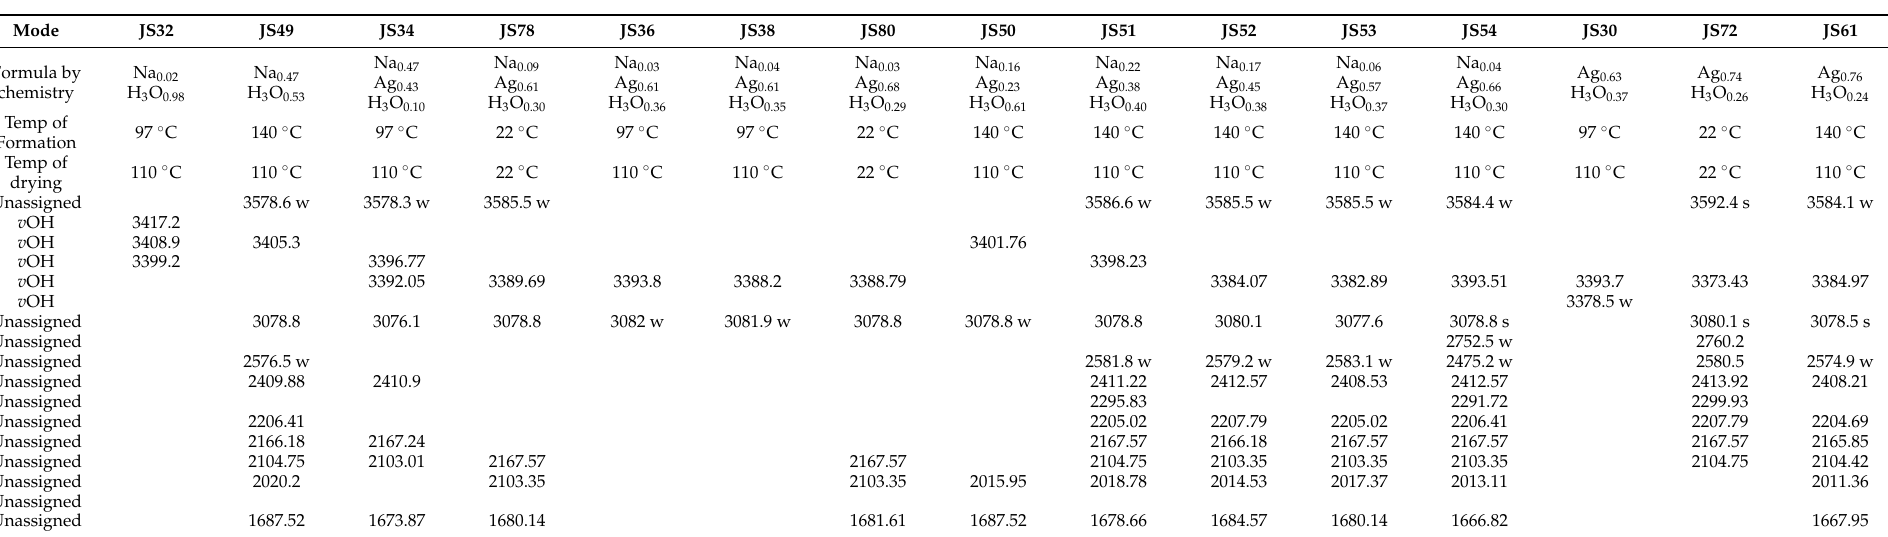
Table 5. Raman frequencies (wavenumber, cm − 1 ) and mode assignment for synthetic Na-Ag-H 3 O jarosite compounds. Key: B-O * = B-O (or OH-O, Frost et al., 2006b); † = similar peak and assignment reported at http://www.sci.qut.edu.au/sci_schps.html (accessed on 14 February 2016); # assigned to δ (H 2 O) in the